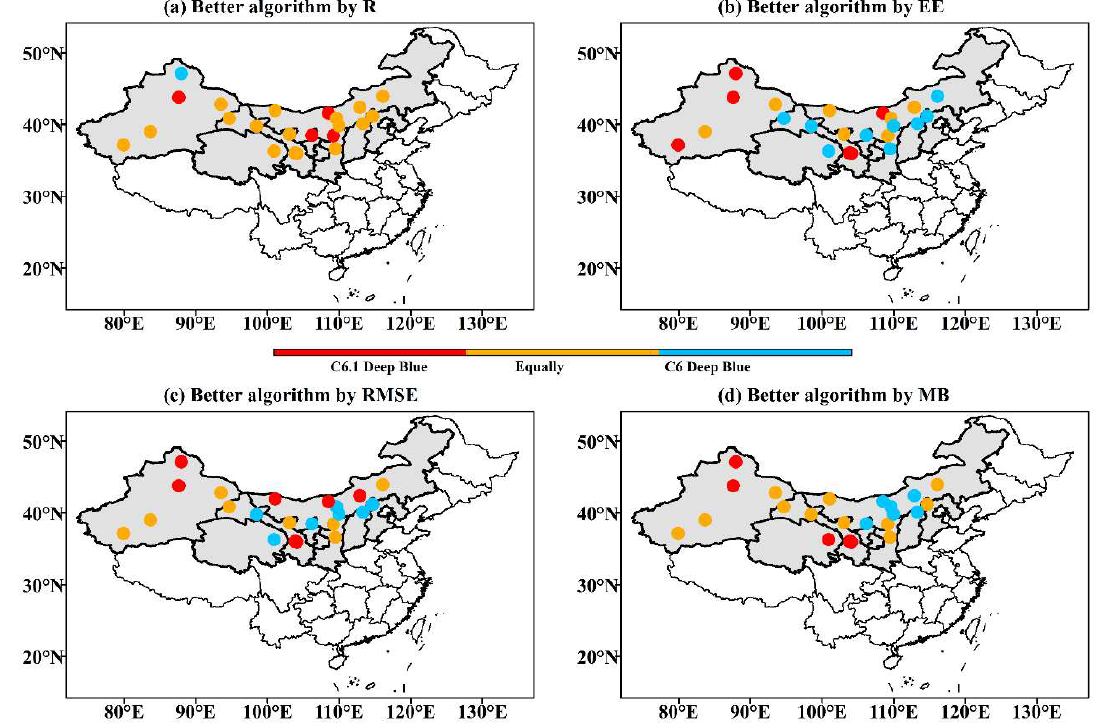
Figure 9. Maps showing the best performing of the MODIS DB products for the following statistical metrics: ( a ) correlation coefficient, ( b ) fraction of points within the EE, ( c ) RMSE, and ( d ) MB.